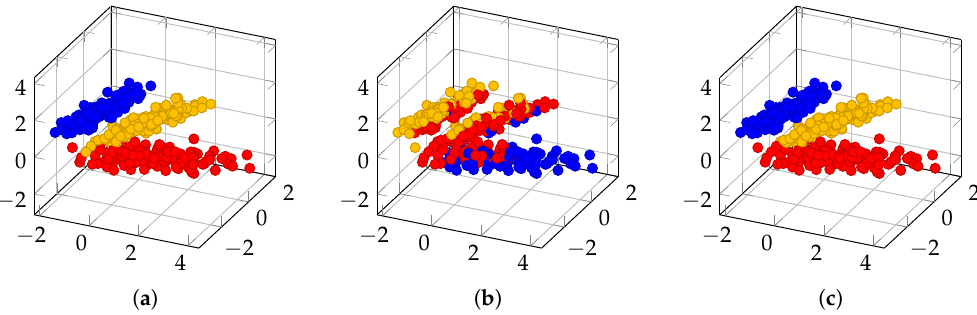
Figure 5. ( a ) Simulated distributions of three spectral species (blue, yellow, red) in a 3-dimensional space. ( b ) Clustering of the three distributions with PCA and k -means. ( c ) Clustering of the three distributions with Gaussian mixture